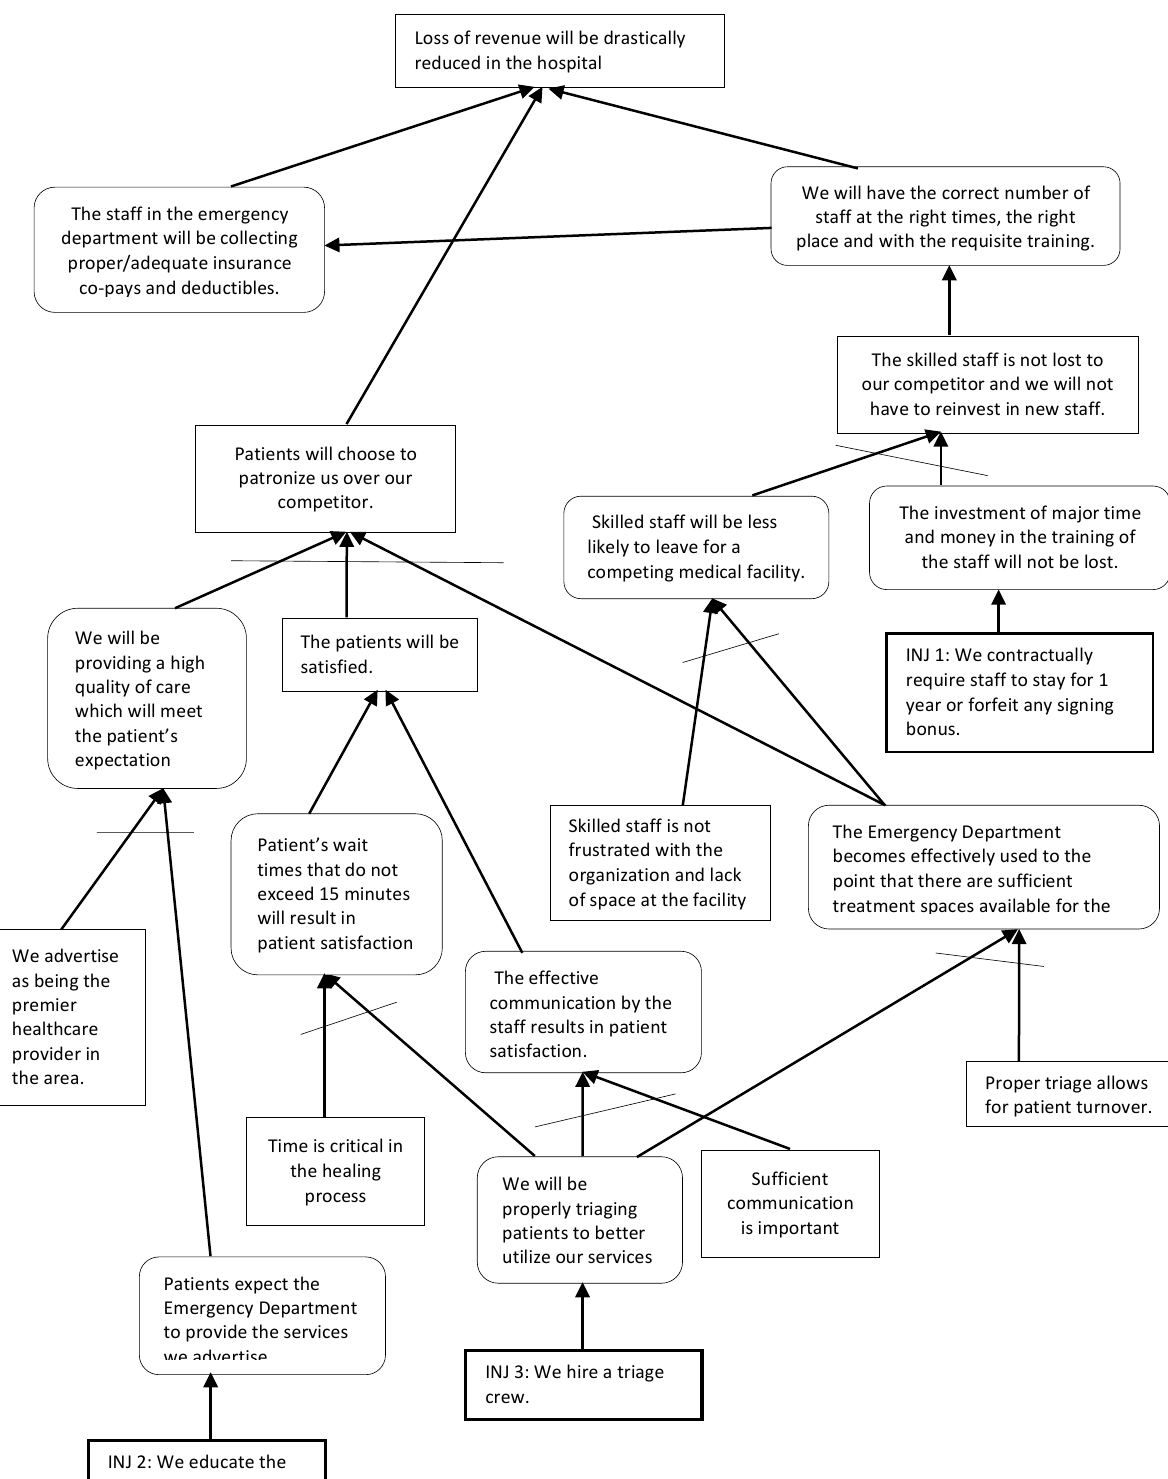
Figure 4. Future Reality Tree of Goldratt’s Theory Applied to the Problems Associated with an Emergency Department at a